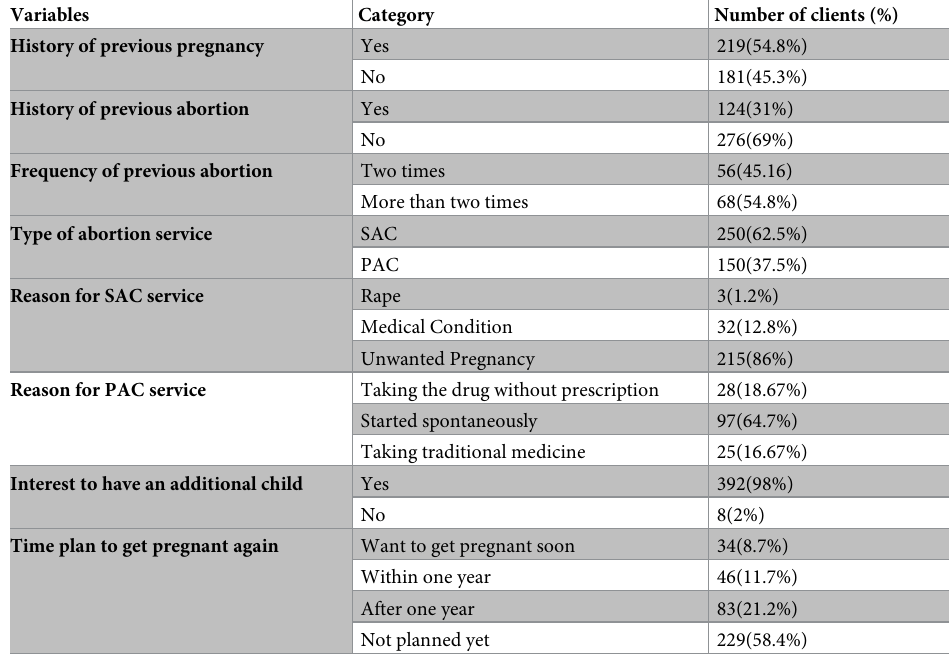
Table 2. Reproductive history of post-abortion clients, Wolaita Sodo,